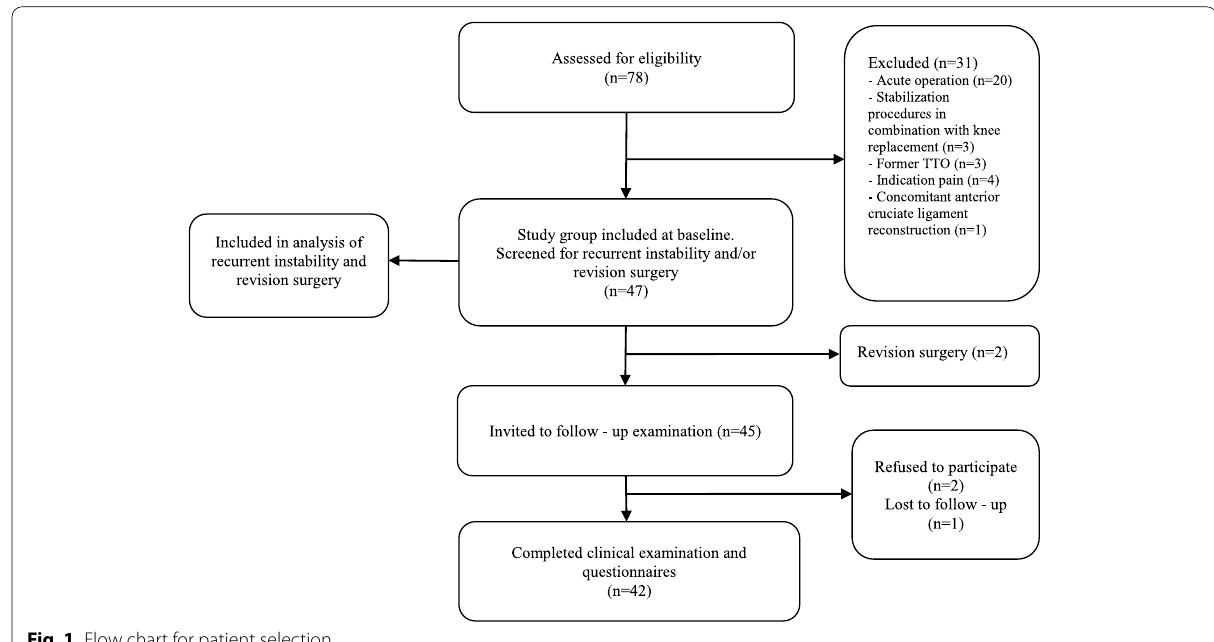
Fig. 1 Flow chart for patient selection